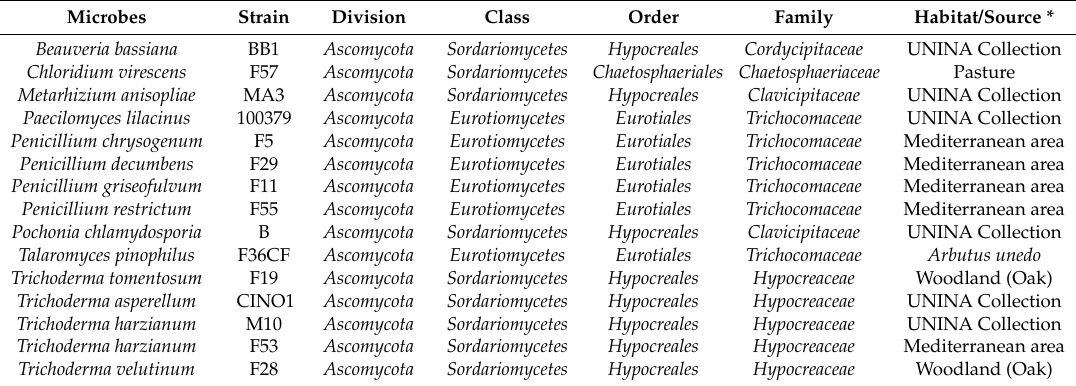
Table 4. Fungal strains used in the present study for the isolation of metabolites with insecticidal activity against the pea aphid A. pisum